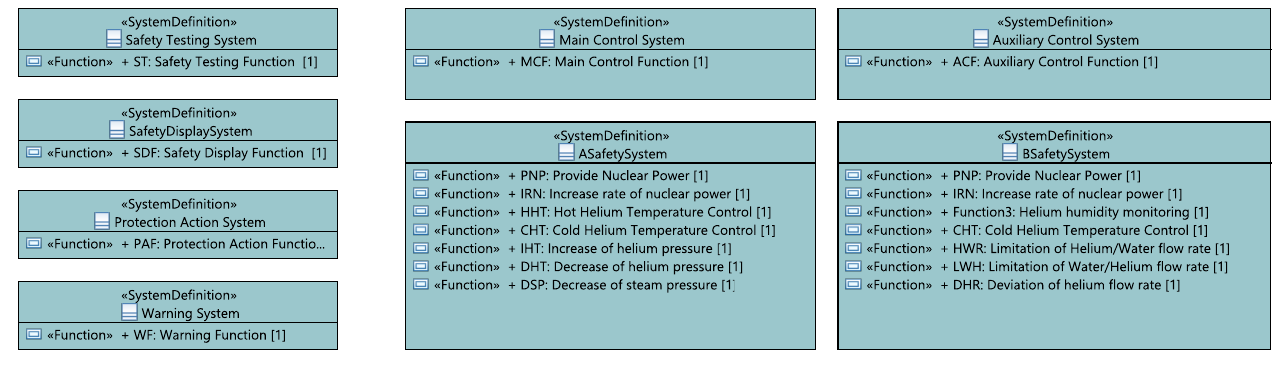
Figure 14. RPS systems.